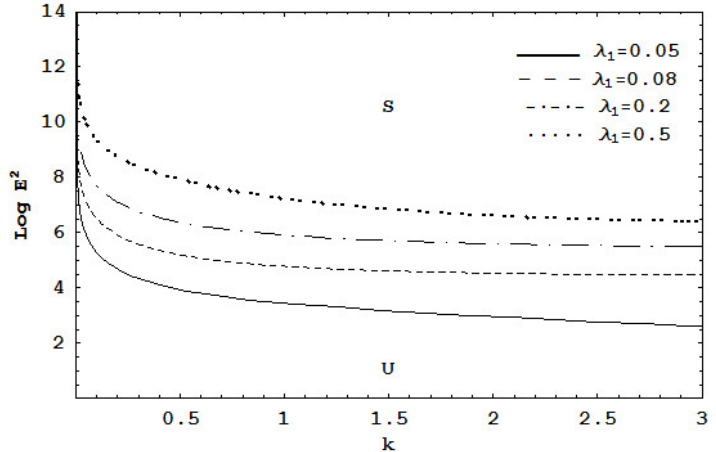
Figure 9. Variation of the electric field intensity log E 2 permeability of the medium, λ 1